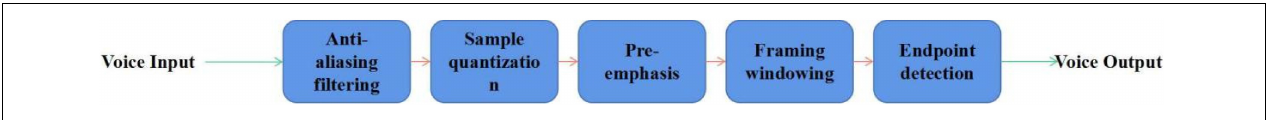
FIGURE 2 | The process of speech signal